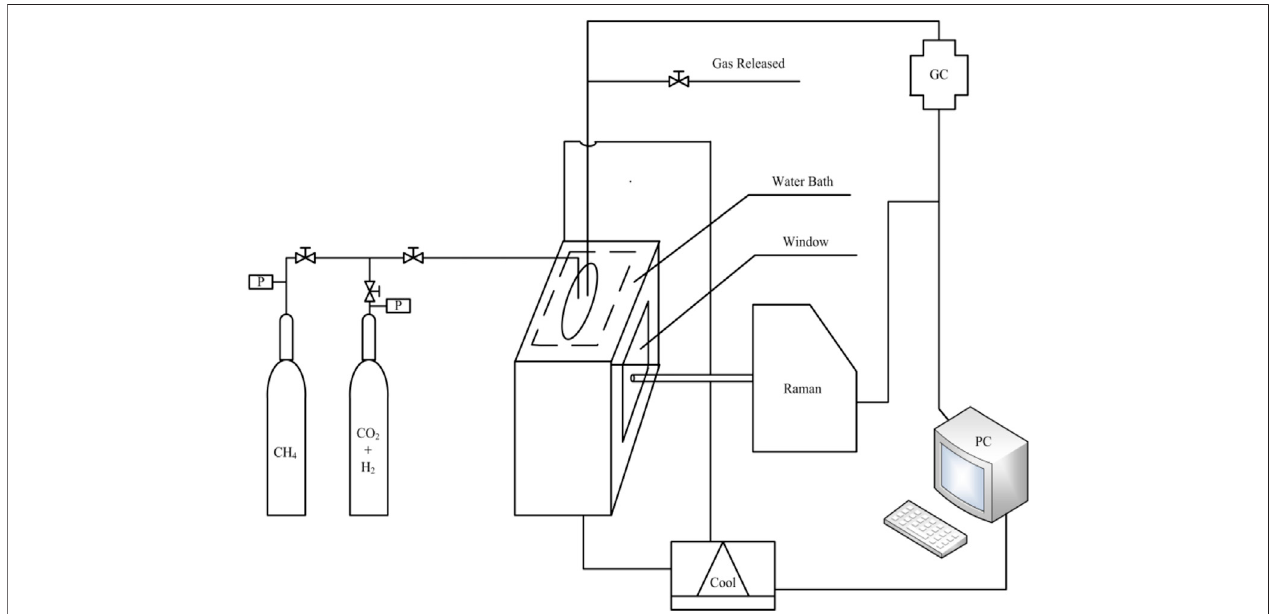
FIGURE 1 | The diagram of experimental